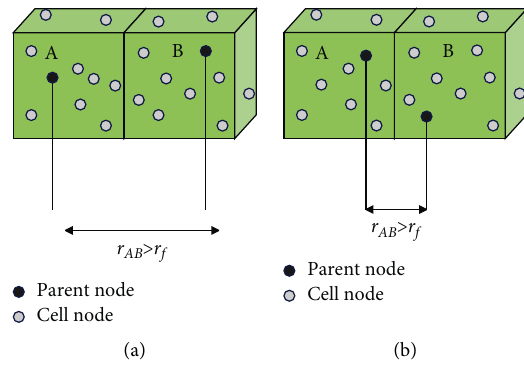
Figure 8: Data fusion judgment